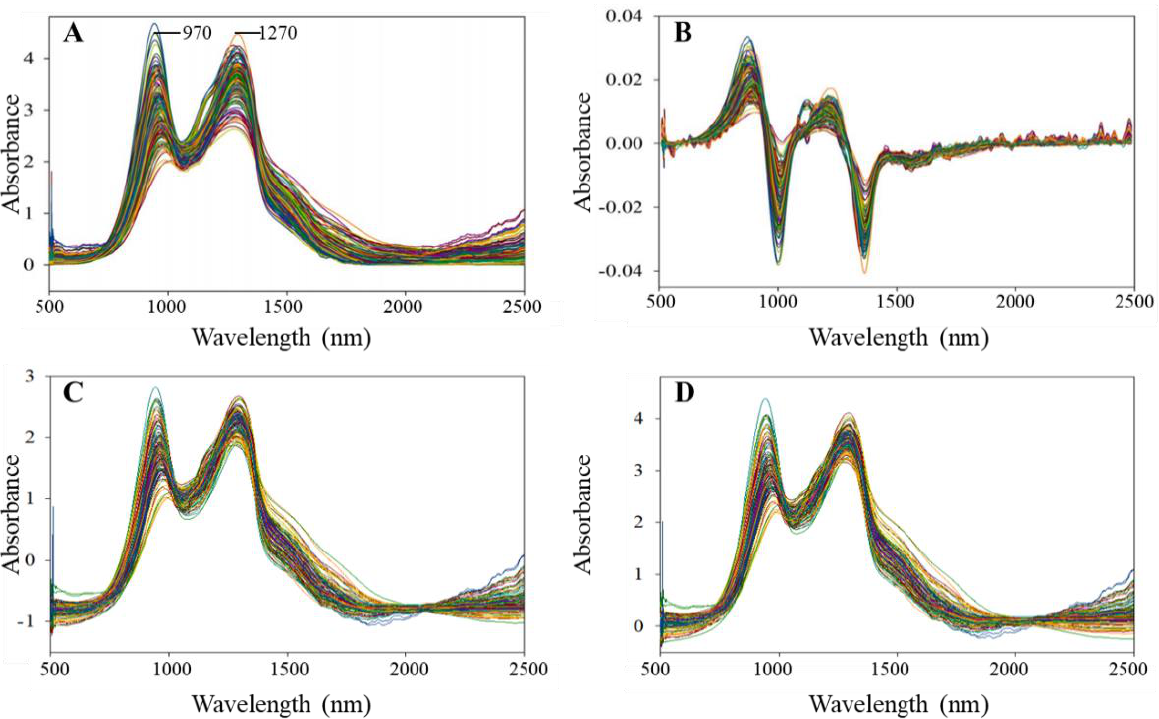
Figure 5. ( A ) NIR raw spectrum. Preprocessed spectrum captured through ( B ) Savitzky–Golay derivative (S–G), ( C ) standard normal variate (SNV), and ( D ) multiplicative scattering correction (MSC) for the sweet potatoes.